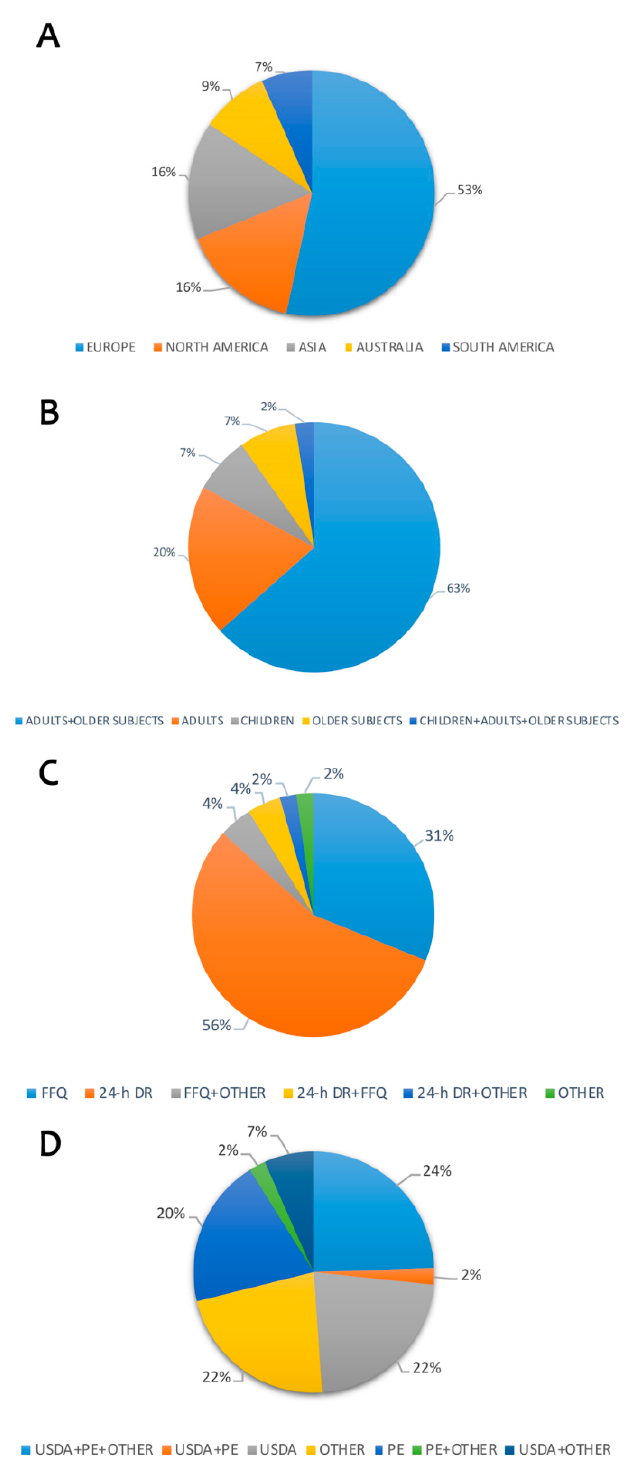
Figure 3. Estimation of polyphenols intake among countries. Legend: ( A ) Target population considered; ( B ) Distribution of published data by country; ( C ) Questionnaires used to evaluate food intake; ( D ) Polyphenol database used for evaluation of intake. FFQ: Food Frequency Questionnaire; 24-h DR: 24-h Dietary Recall; USDA: United States Department of Agriculture; PE: Phenol-Explorer.